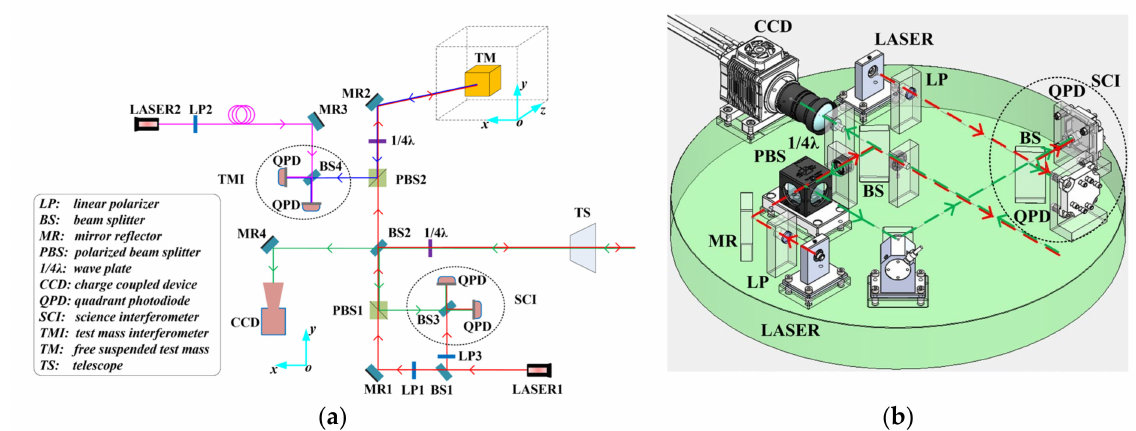
Figure 8. Schematic diagram of single interference platform: ( a ) the optical path design; ( b ) the 3D model of a single interference platform with only